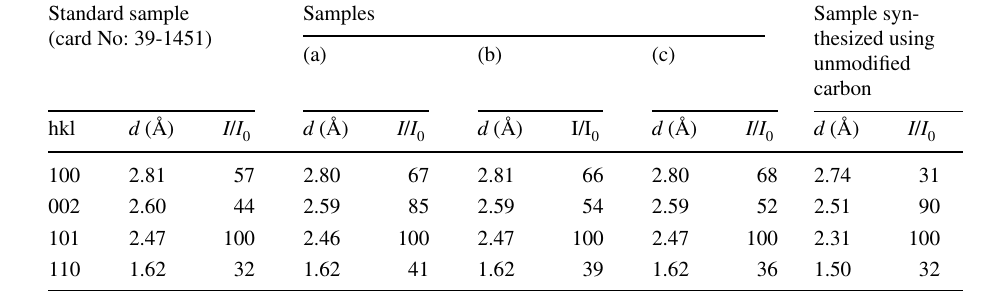
d distance between plates in terms of angstrom, I peak intensity, I 0 maximum intensity to the planes 100 and 002, 101 and